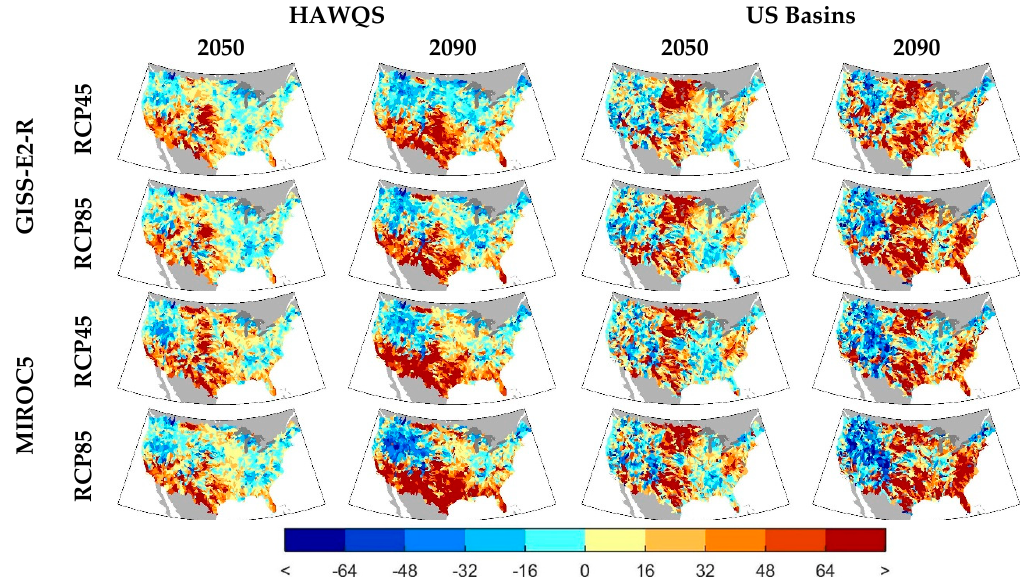
Figure 9. Percentage changes in mean ( left ) HAWQS and ( right ) US Basins phosphorus concentrations at the HUC ‐ 8 watershed scale for both the GISS ‐ E2 ‐ R and MIROC5 climate models, two emissions scenarios, and two eras.